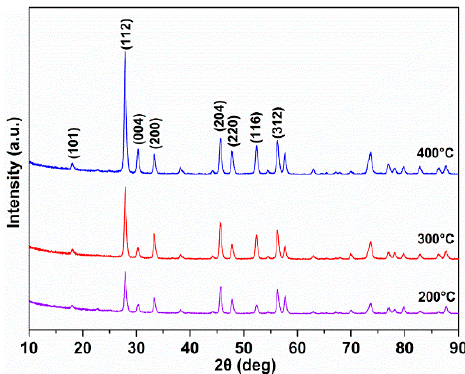
Figure 13. The Raman spectra of the worn surface after sliding friction test lubricated with oil containing 0.5 wt% AgReO 4 additive at 400 °C.